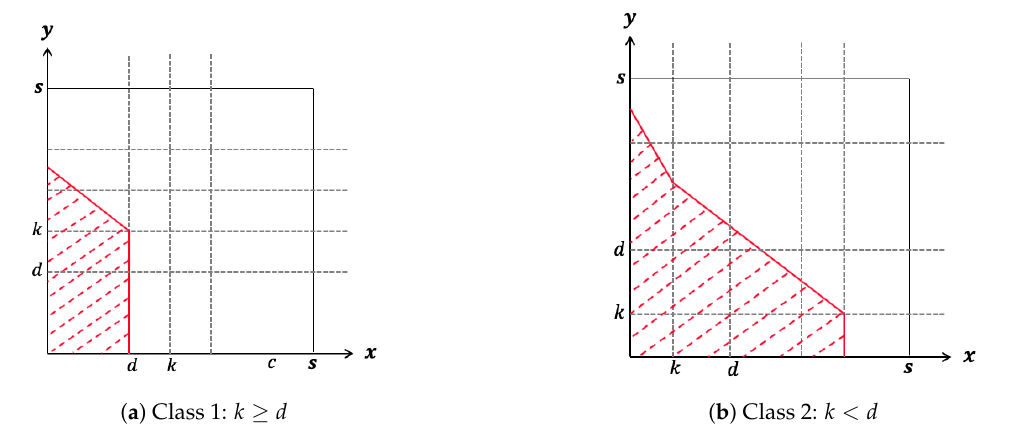
Figure 4. No-bank run border for one bank under the strategy of exchanging only the junior tranche.